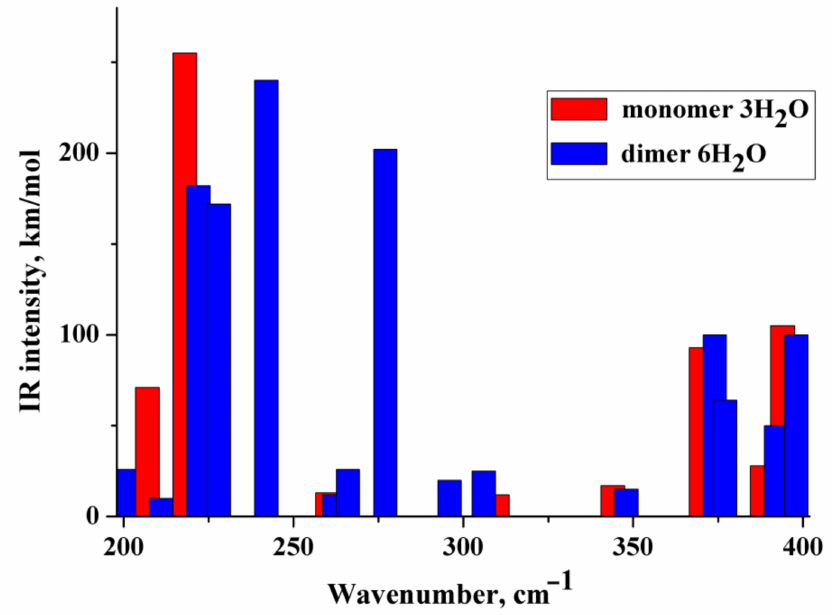
Figure 4. Theoretical IR spectra of the diclofenac anion hydrated with three water molecules (red columns) and dimer of the diclofenac anion hydrated with six water molecules (blue